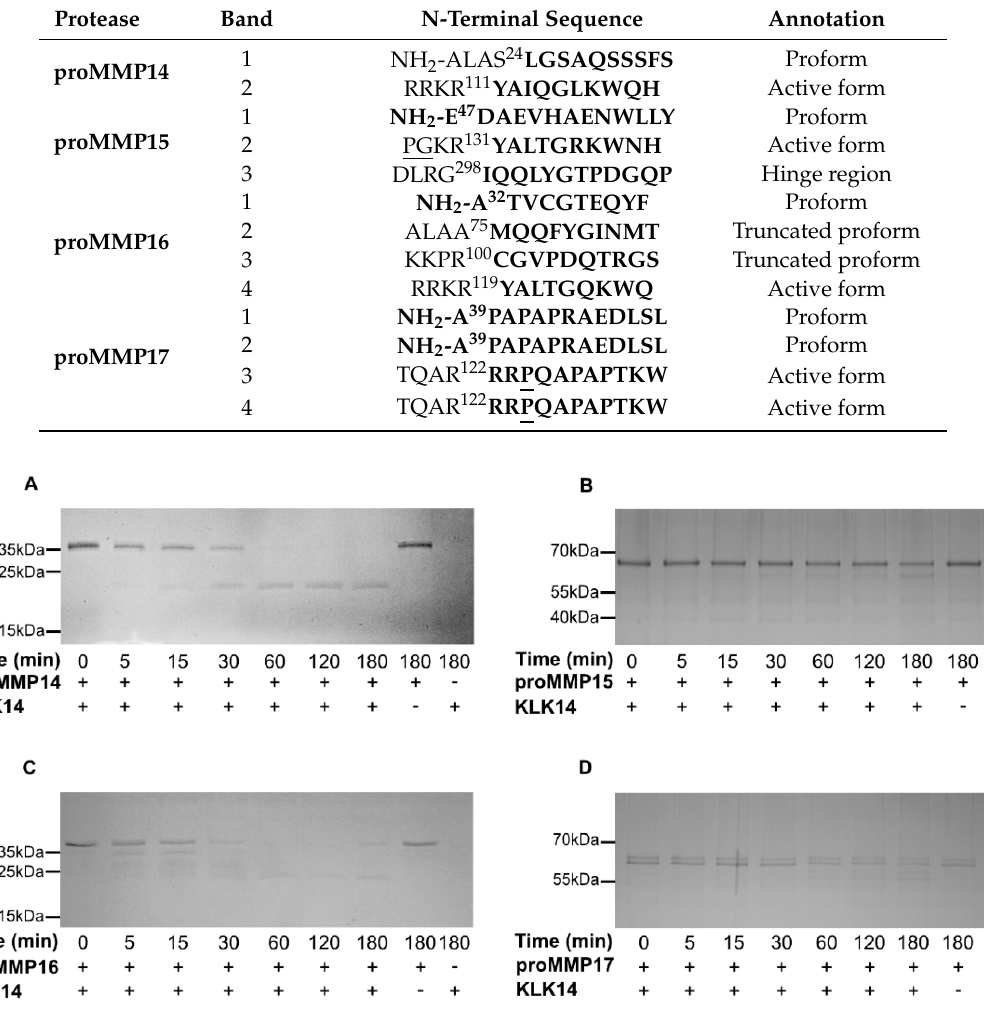
Figure 3. Recombinant human proMMP14,15, 16, and 17 are processed by KLK14 in a time